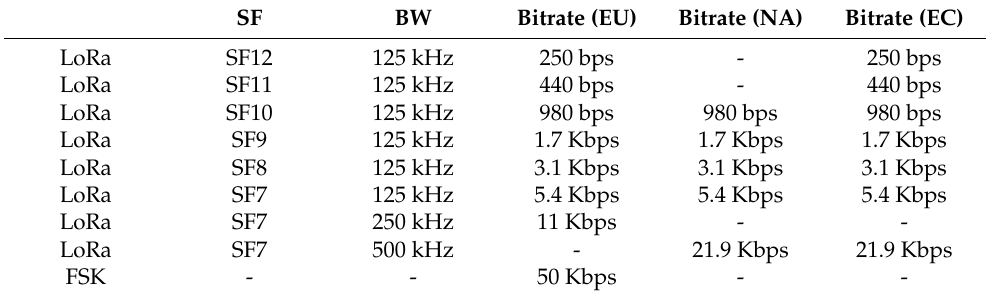
Table 3. Comparative chart of Long Range (LoRa) Spreading Factor (SF) parameters according to the analyzed